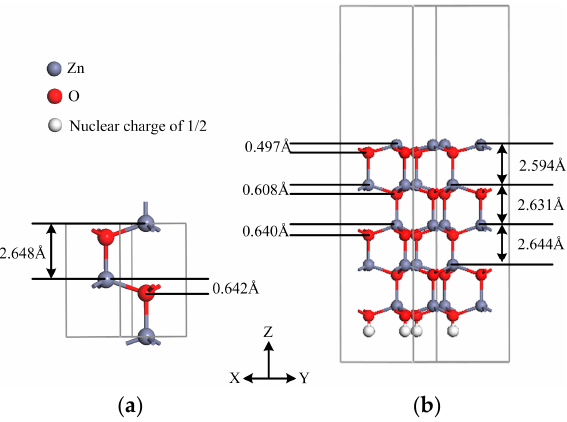
Figure 2. Schematic models of ( a ) the bulk wurtzite ZnO unit cell and ( b ) the pristine (2 × 2) (0001) surface.